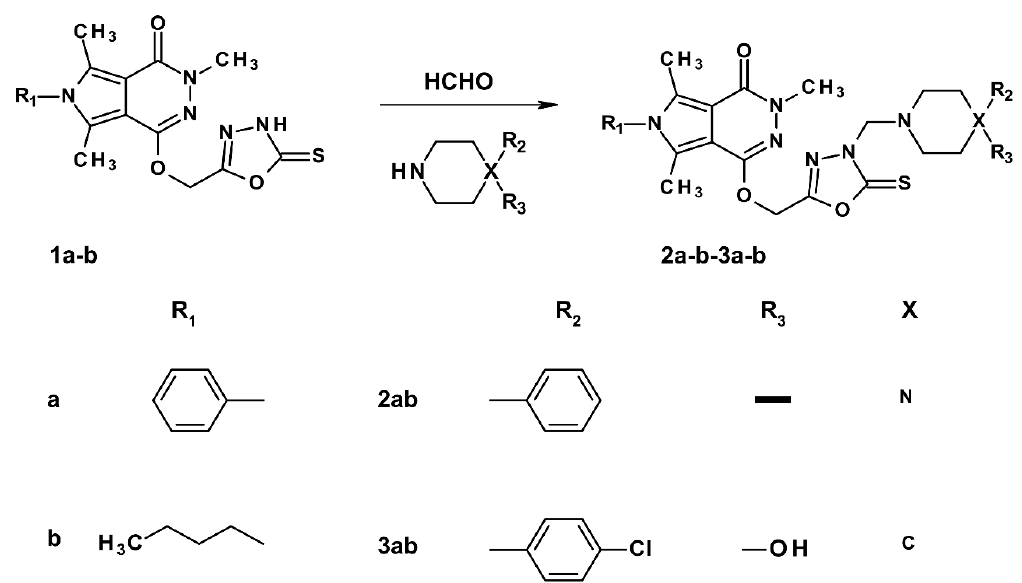
Figure 2. Synthesis and structures of examined derivatives of pyrrolo[3,4- d ]pyridazinone.